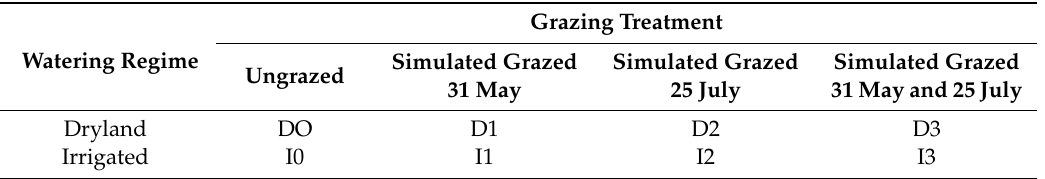
Table 2. Identification of the experimental